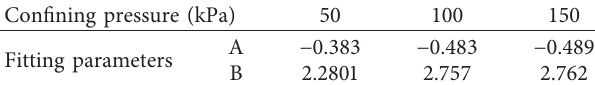
Table 3: Parameters under different confining pressures.